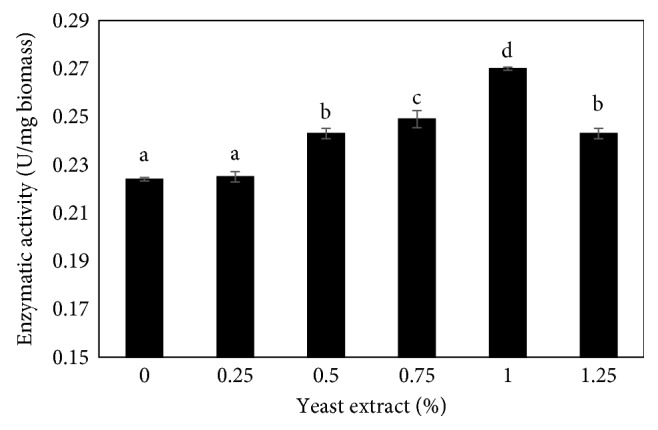
The effect of the concentration of yeast extract on glucose isomerase production. Yeast extract provides nitrogen for production of glucose isomerase but high concentration will inhibit the bacterial growth. In this study, we determined the optimal concentration of yeast extract is 1%. Addition of yeast extract (0–1%) in induction medium resulted in an increase of enzyme activity, but yeast extract also exhibited the inhibitory effect in high level (1.25%). a, b, c, and d indicate the significant difference between groups.